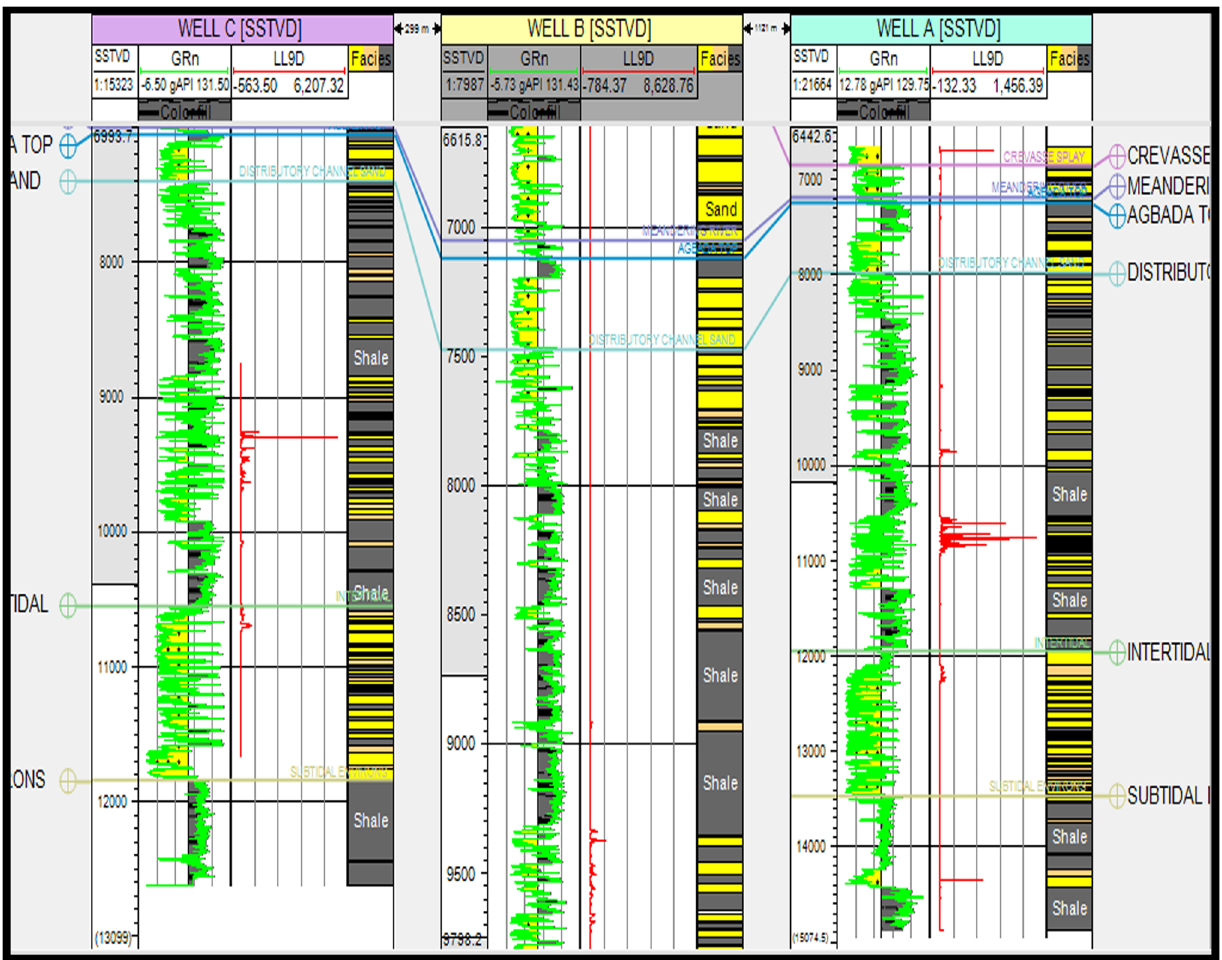
Fig. 5 Correlation of well A, well B and well